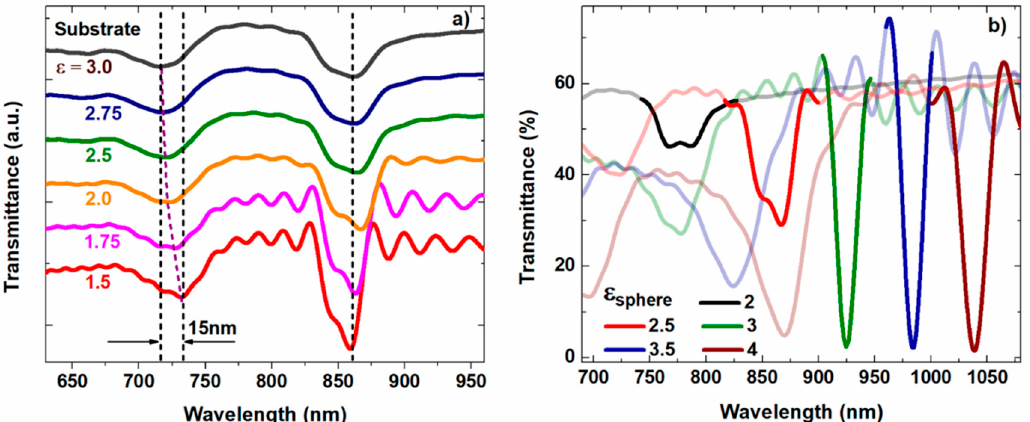
Figure 4. Simulated transmission spectra of a close-packed monolayer of 701 nm PS beads on a dielectric substrate ( a ) fixing ɛ (cid:3046)(cid:3043)(cid:3035)(cid:3032)(cid:3045)(cid:3032) = 2.25 while the dielectric constant of the substrate varies in the range of 1.5 to 3 and ( b ) keeping ɛ (cid:3046)(cid:3048)(cid:3029) = 2.5 while the dielectric constant of the dielectric spheres changes from 2 to 4.